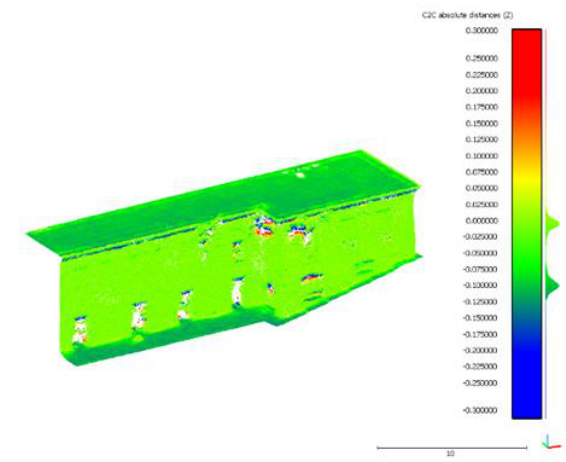
Figure 3 . Distances along the z axis resulting from the Cloud- to-Cloud application without registration of the two clouds.